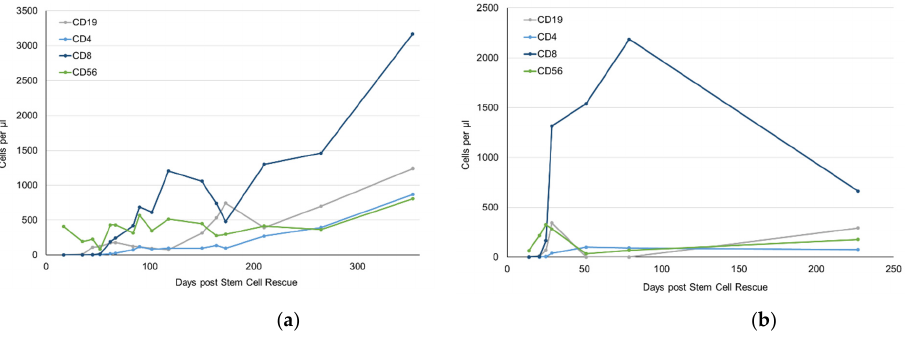
Figure 5. Immune reconstitution after immunoablative therapy in ( a ) case 1 and ( b ) case 2.